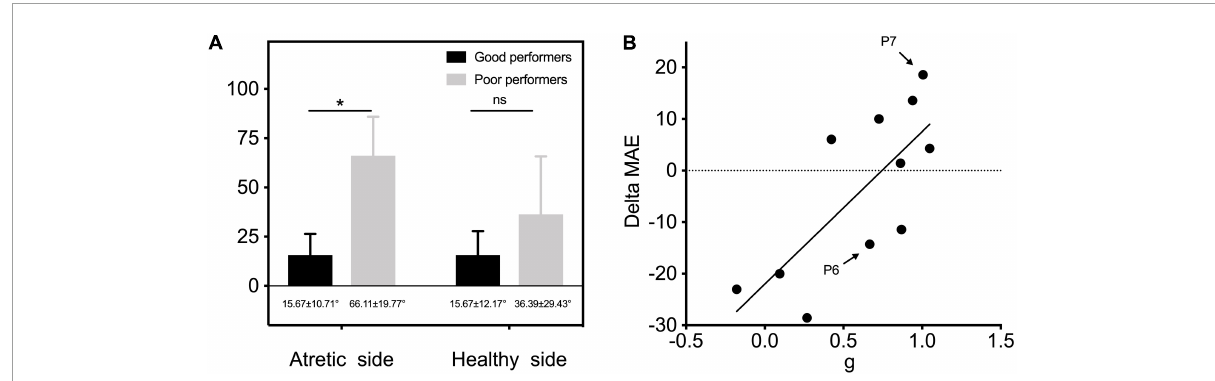
FIGURE7 (A) MAE outcomes of two subgroups of good performers ( n = 5; gain > 0.75) and poor performers ( n = 6; gain ≤ 0.75) were separately compared on the atretic and healthy sides. (B) Individual data of gain of UMA children in unaided conditions are plotted as a function of delta MAE between unaided and aided conditions. The linear regression was conducted to explore the predictive effect of gain on the benefits of sound localization accuracy by fitting BCDs. P6 and P7 depicted in Figure 4 are marked in this figure. Delta MAE, aided MAE—unaided MAE. Significant differences, * p < 0.05. ns, not significant; MAE, mean absolute error; g, response